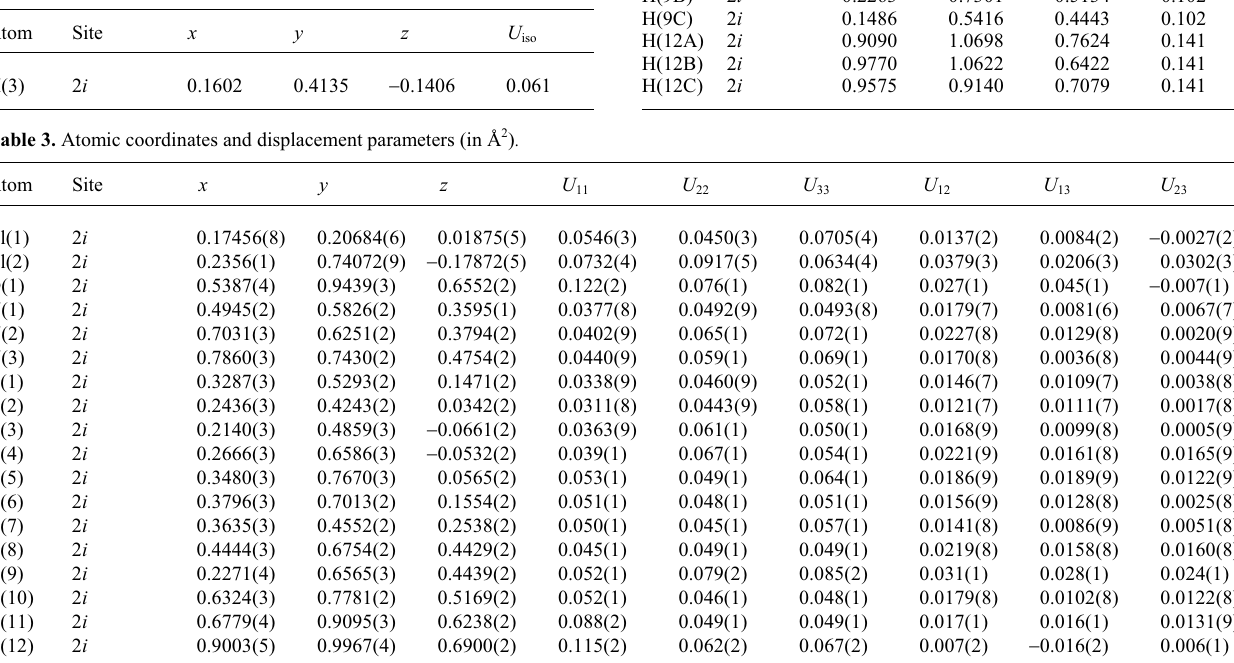
Table 2. Atomic coordinates and displacement parameters (in Å 2 ) .